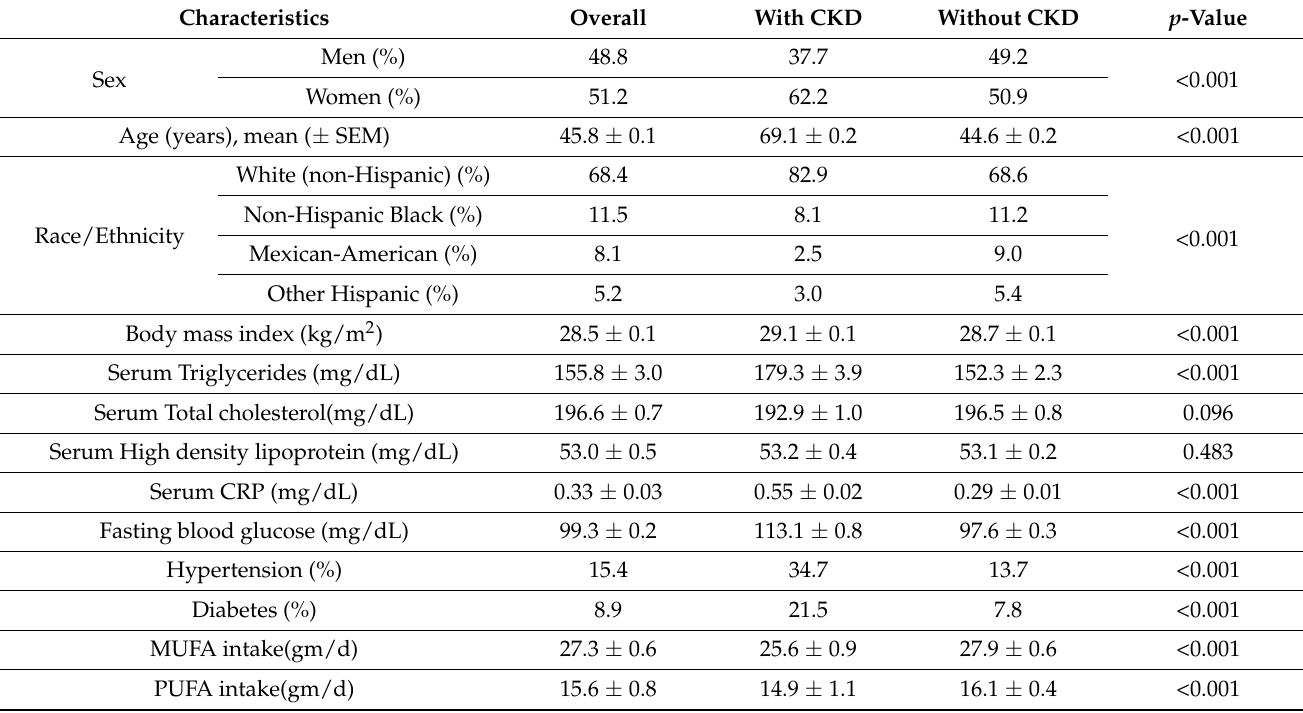
Table 1. Demographic characteristics of subjects for the whole sample and stratified by chronic kidney disease (CKD)